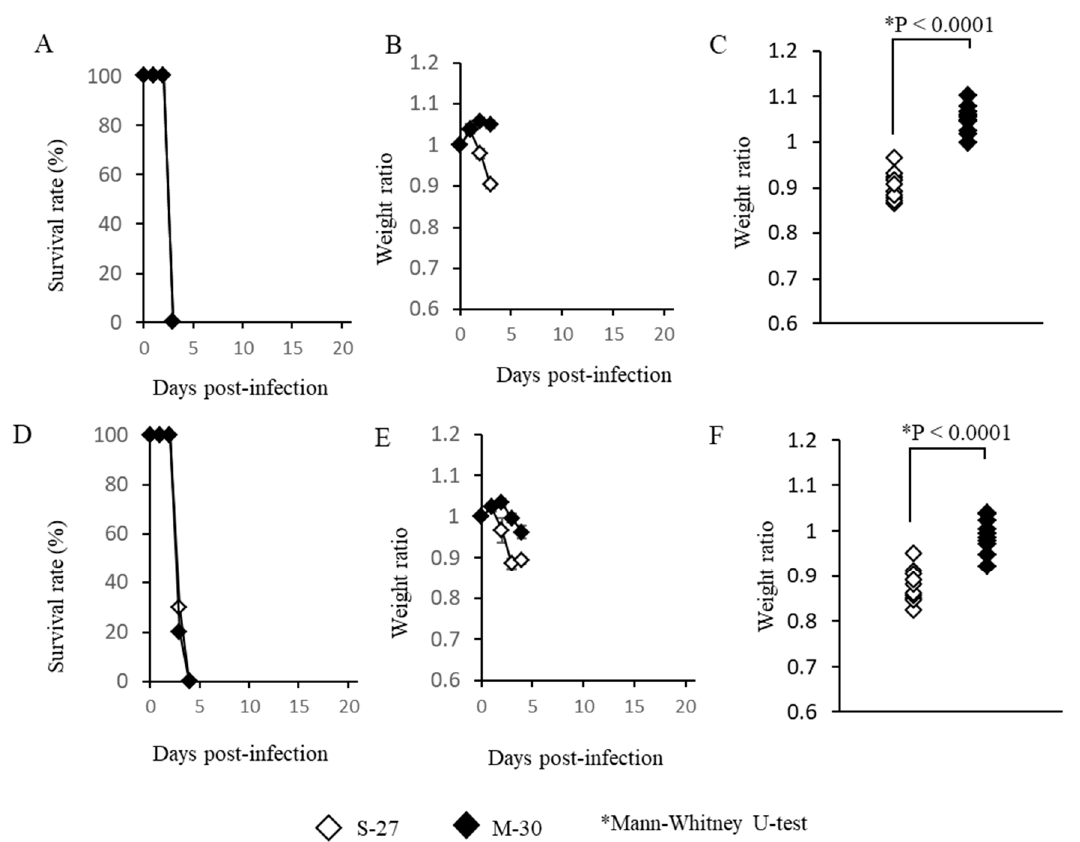
Figure 2. Survival rates ( A , D ), average ratios of weight change ( B , E ) and individual weights when the mice died ( C , F ) of AG129 mice following subcutaneous infection with high titer 10 5 PFU ( A – C ) and low titer 10 2 PFU ( D – F ) of M-30 and S-27 CHIKV strains. The error bars represent the standard deviations. The asterisks show significant differences by the Mann–Whitney U-test, P < 0.05.